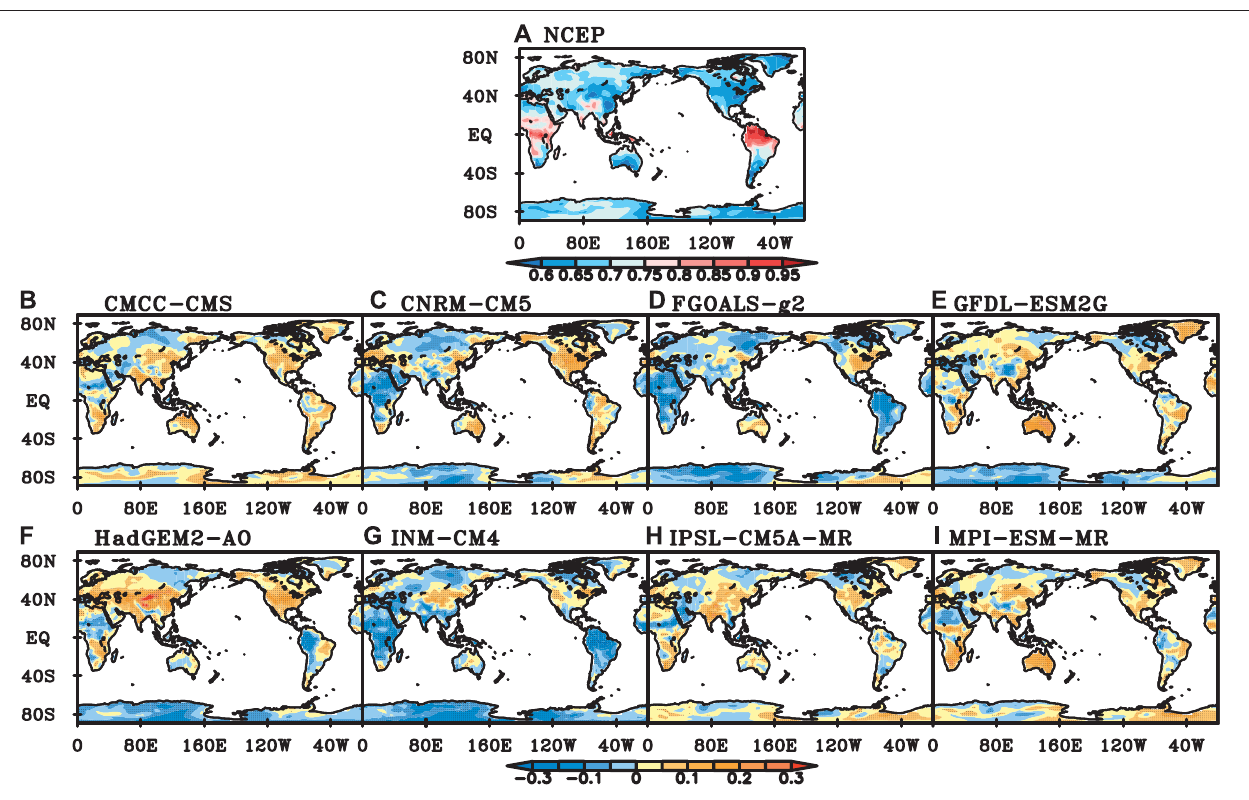
FIGURE6| ScalingexponentsofNCEPSAT (A) anddifferencebetweenNCEPandthoseofSATsimulatedby (B) CMCC-CMS, (C) CNRM-CM5, (D) FGOALS-g2, (E) GFDL-ESM2G, (F) HadGEM-AO, (G) INM-CM4, (H) IPSL-CM5A-MR, (I) MPI-ESM-MR. (Black dot represents the difference is signi fi cant at a signi fi cance level of